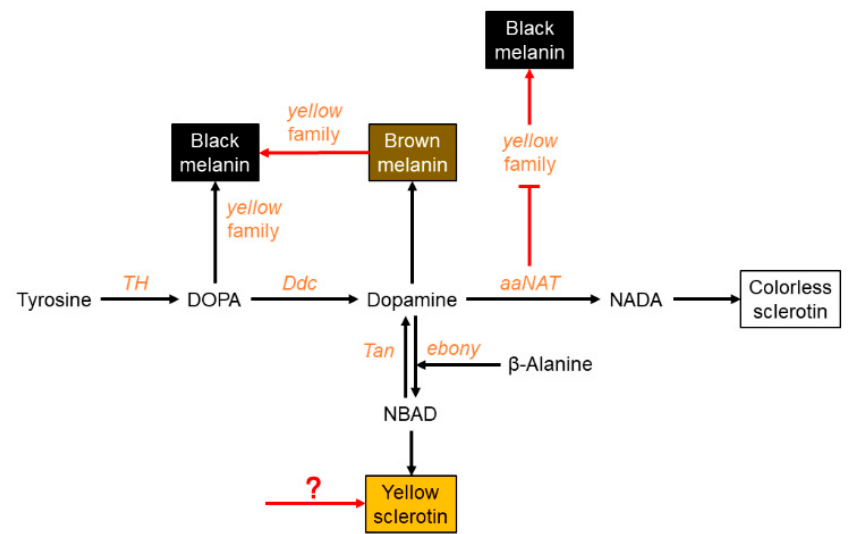
Figure 6. A proposed melanin pathway in P. biguttatus . In this assassin bug, black melanin is solely generated from the melanin pathway, and dopamine melanin is the main precursor of black pigment. However, yellow functions in the process of converting brown melanin to black melanin (red arrow). The yellow pigment of this species is not synthesized by the NBAD branch, but by other pigmentation pathways. In the NADA branch, aaNAT acts as an “eraser” to maintain the white spot on the preliminary black background. Furthermore, aaNAT can inhibit yellow expression, thereby inhibiting the formation of black melanin (red suppression